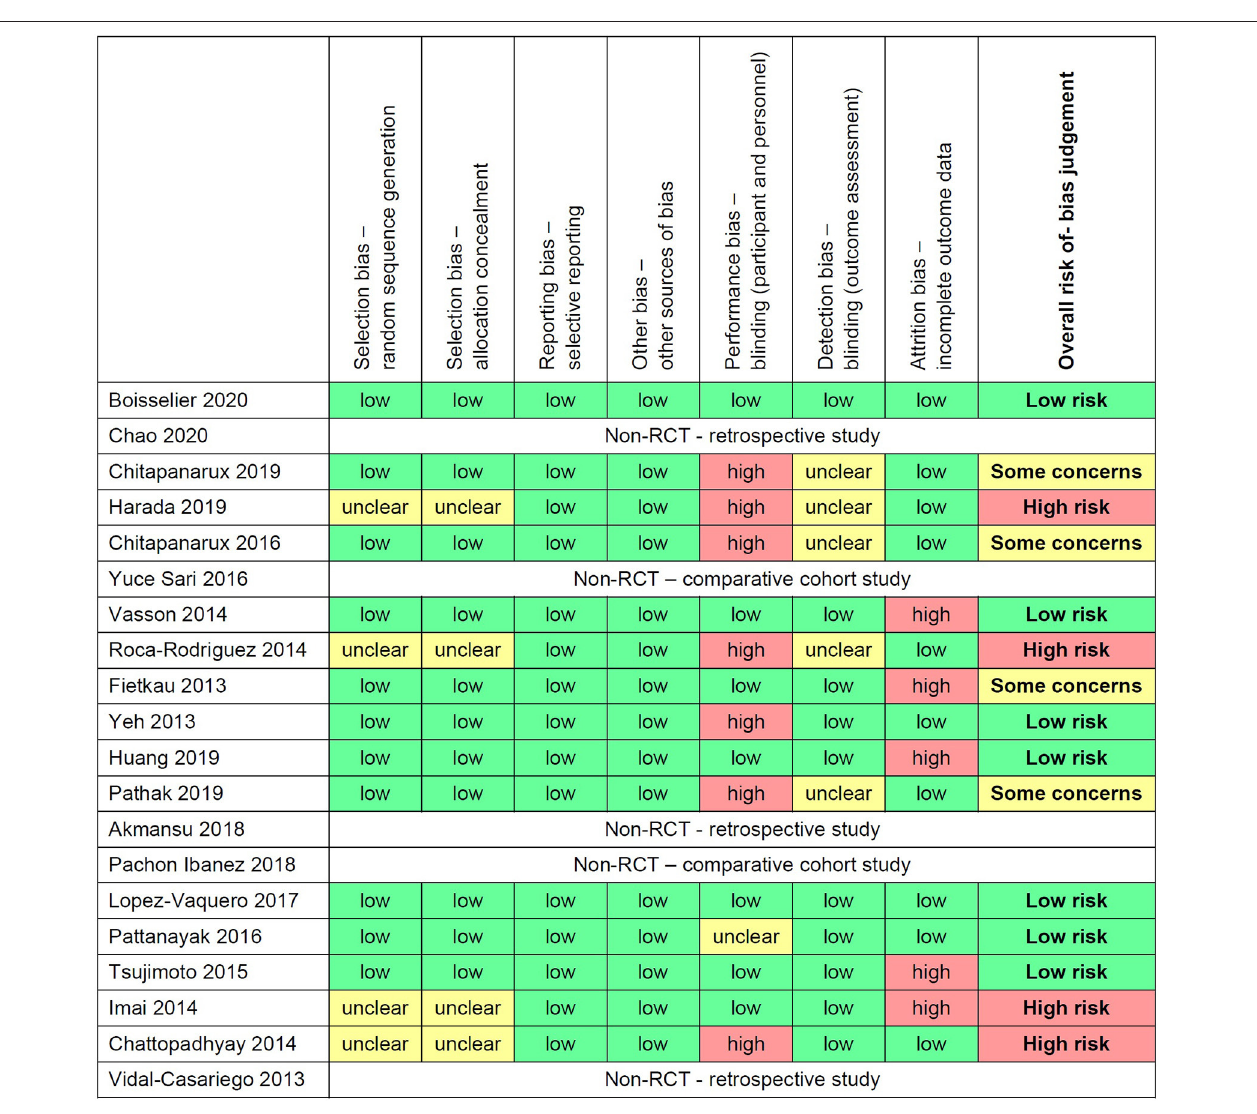
3 and 5. Two studies were of poor methodological quality, and three other studies were non-randomized controlled